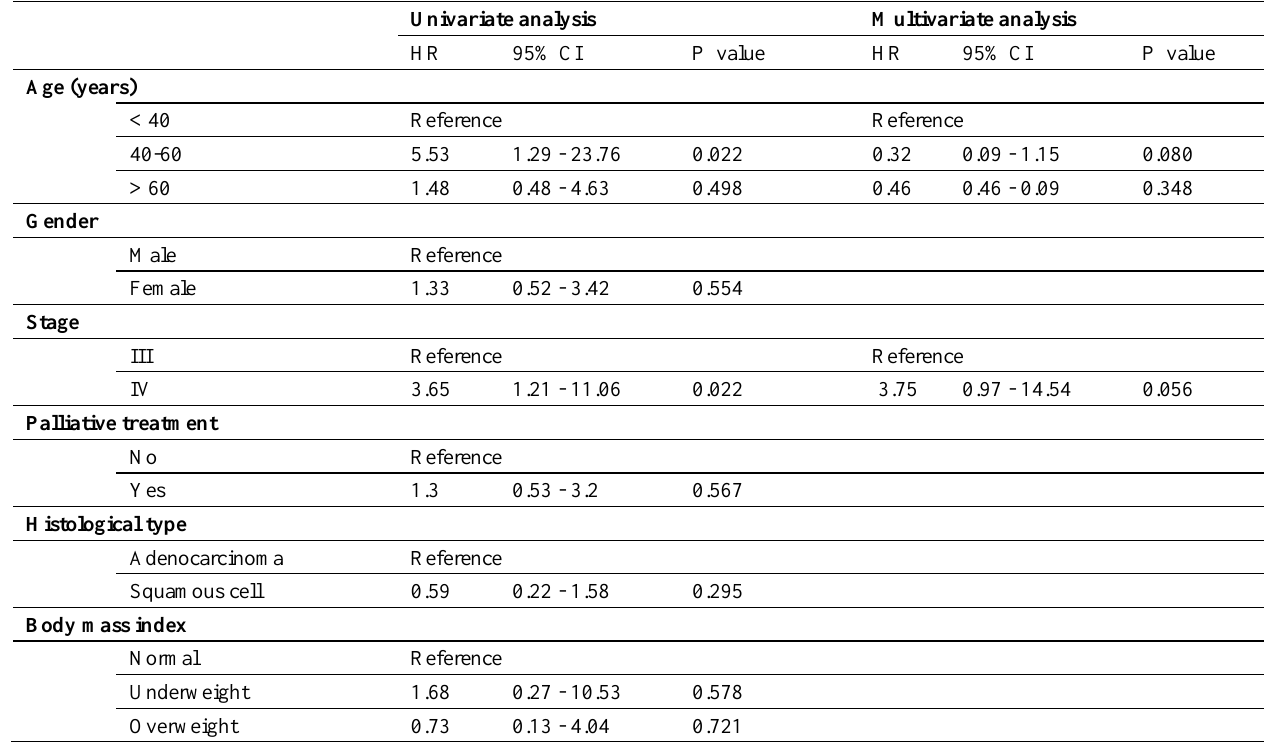
Table 3: Prognostic factors by Cox regression analysis Univariate analysis Multivariate